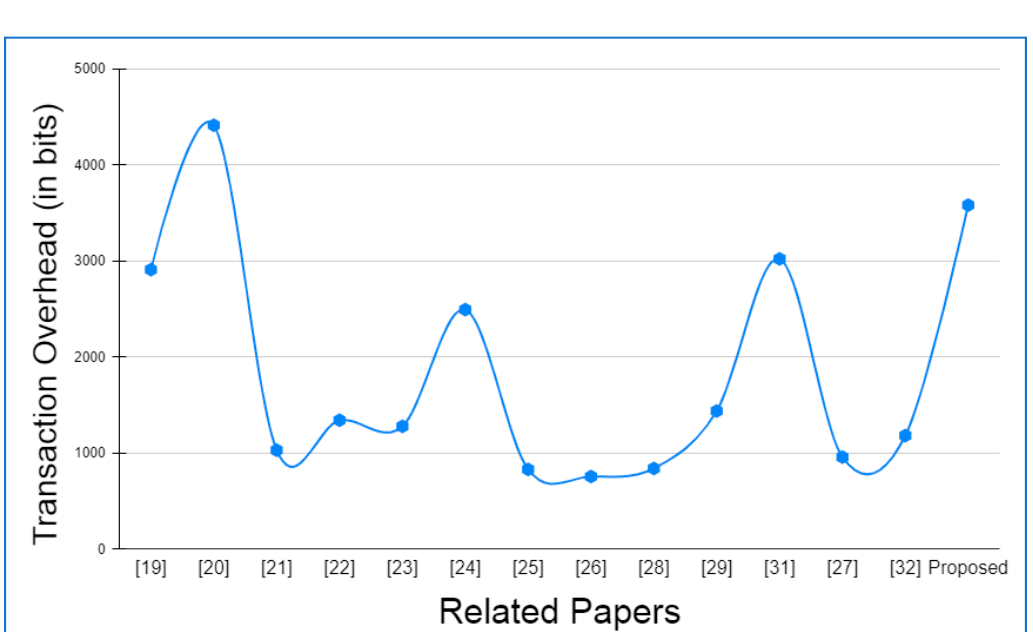
Figure 14. Transaction Overhead Relative Comparison.